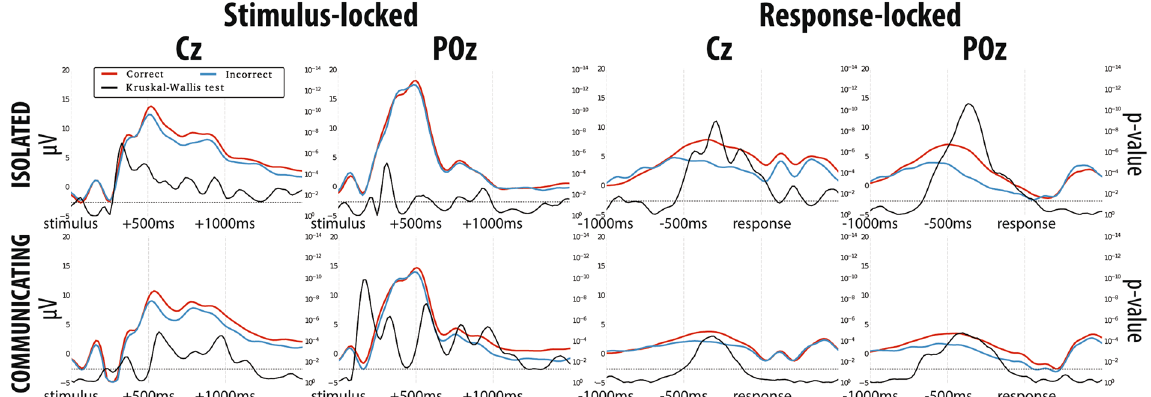
Figure 6. Grand averages of stimulus-locked and response-locked ERPs for the correct (red) and the incorrect (blue) sets and corresponding temporal profile of the KW p -values (black) for representative channels Cz and POz for Experiments 1b (first row) and 2 (second row). The horizontal dotted line represents the 5% significance level.